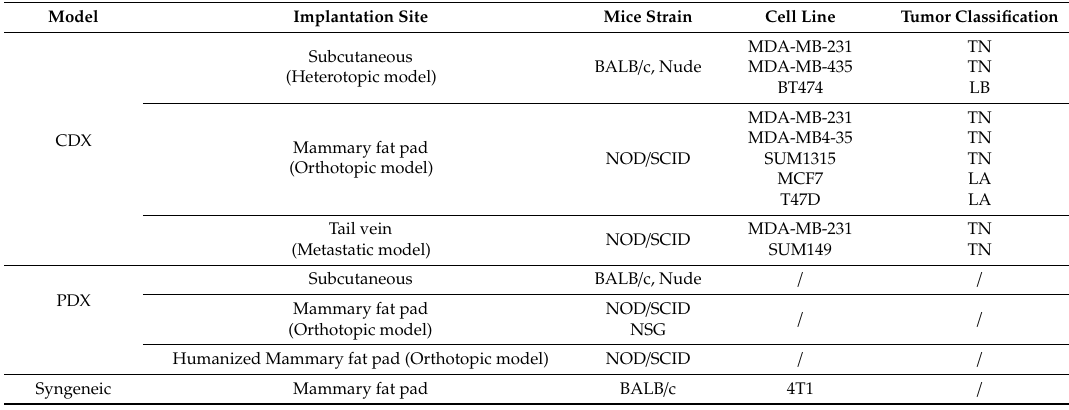
Table 3. Summary of breast cancer cell-derived xenograft (CDX), patient-derived xenograft (PDX), and syngeneic mouse models